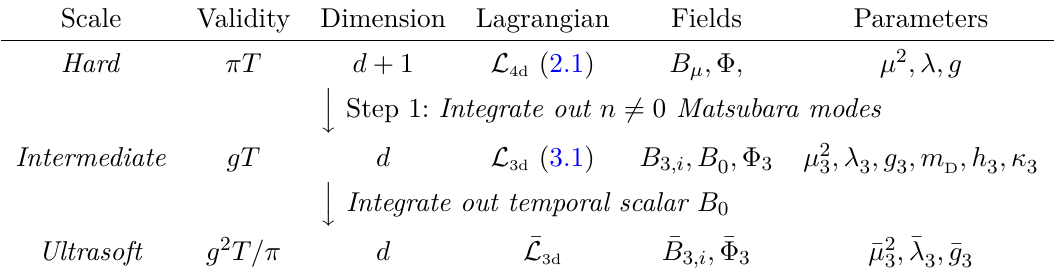
Table 1 . Conventional dimensional reduction of ( d + 1)-dimensional Abelian Higgs model into effective d -dimensional theories based on the scale hierarchy at high temperature [64]. The effective couplings are functions of the couplings of their parent theories and temperature and are determined by a matching procedure. The first step integrates out all hard non-zero modes. The second step integrates out the temporal scalar B 0 with soft Debye masses m . Lattice studies of thermody- D namics in this model [111–113, 118, 119] were performed at the ultrasoft scale, where only ultrasoft spatial gauge fields B r (with corresponding field-strength tensors F rs ) remain along with a light Higgs that undergoes the phase transition. In our perturbative computation for bubble nucleation, Φ 3 is not assumed to be ultrasoft and hence we do not perform the second reduction to the ultrasoft scale, but instead construct nucleation EFT; see table